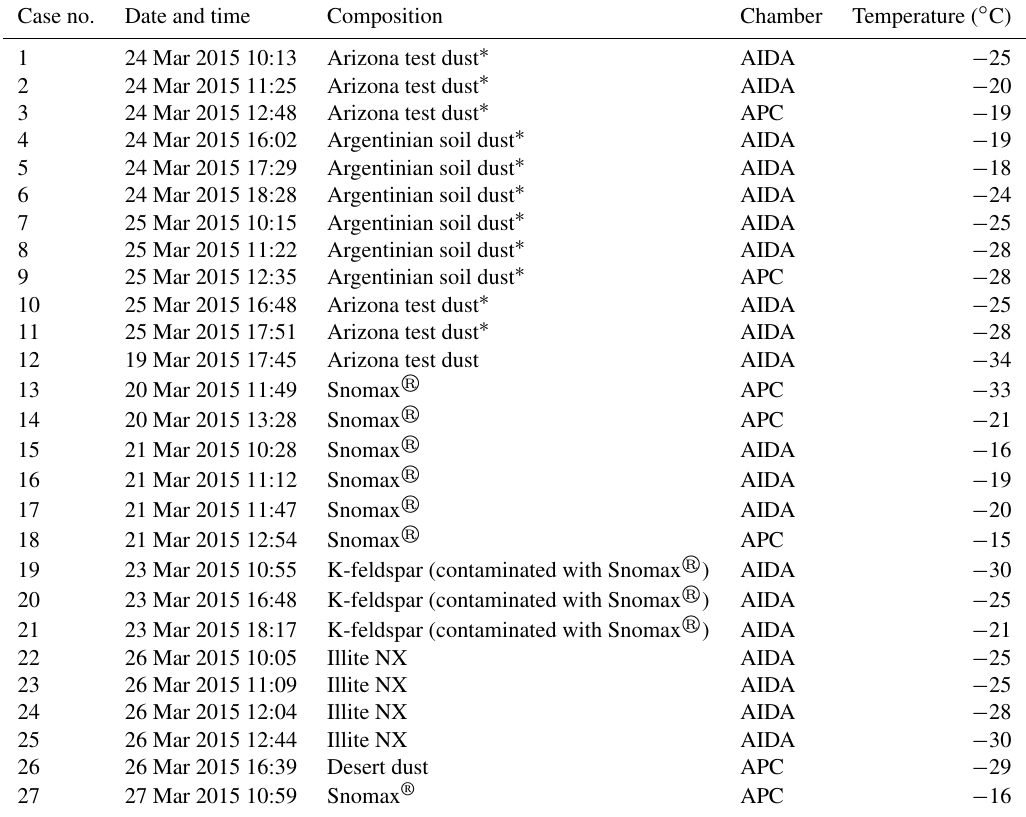
Table 1. Date and time (CET), the composition of aerosol sampled, and the CFDC operating temperature ( ± 1.5 ◦ C). Case